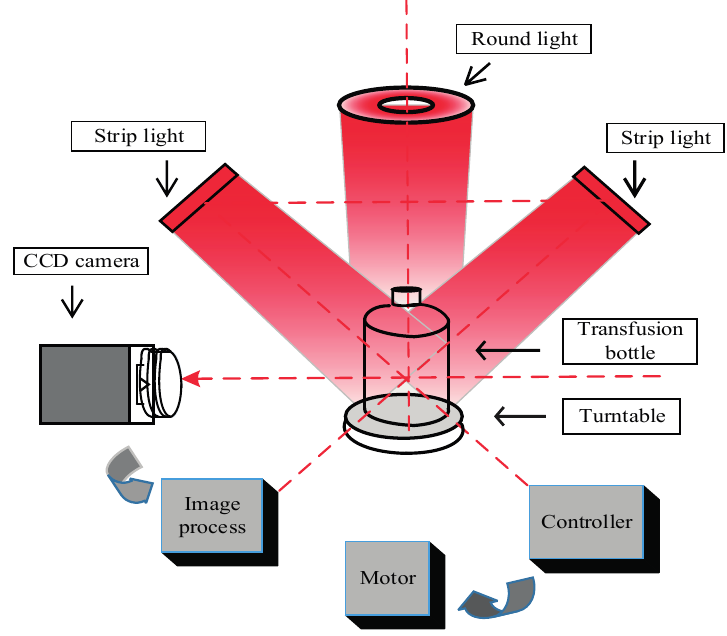
Figure 1. The framework of the detection system for a plastic transfusion